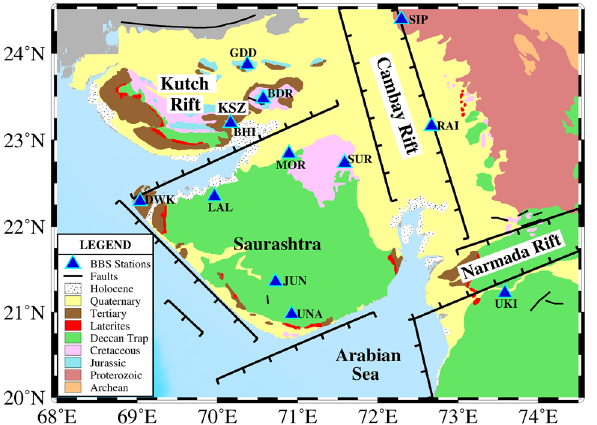
Figure 1. The distribution of 12 selected BBS stations superimposed on the geological map of Gujarat, northwest India. The major geographical regions are also marked. The Kutch, Cambay and Narmada rift basins are indicated using thick black lines. This figure is prepared using PyGMT (v0.3.0; https:// www. pygmt. org/ v0.3. 0/) 24